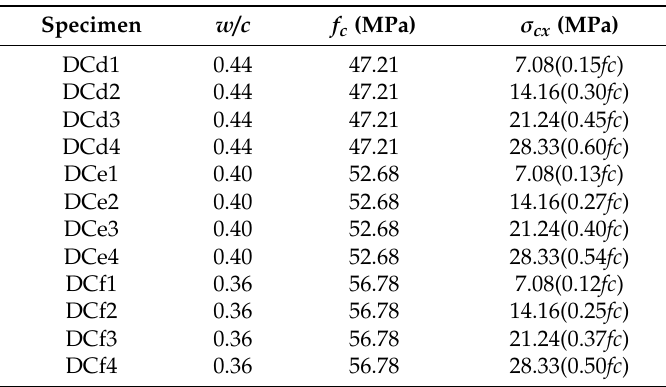
Figure 2. Biaxial loading. Table 3. Test specimens under uniaxial stress.